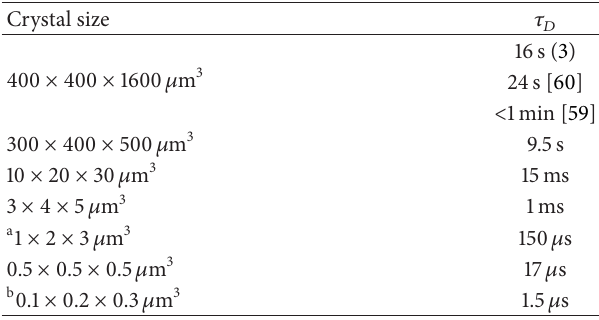
Table1:Diffusiontimes 𝜏 𝐷 forvariouscrystalsizesfromcalculation, simulation, and